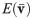
E-P-ϕ surf graph.Fig 7 (a)-(j) illustrates the relationship among E-P-ϕ in different districts; the upper layer represents E(v¯) without tolls (g/h), and the lower layer represents E(v^) with differentiable tolls (g/h).